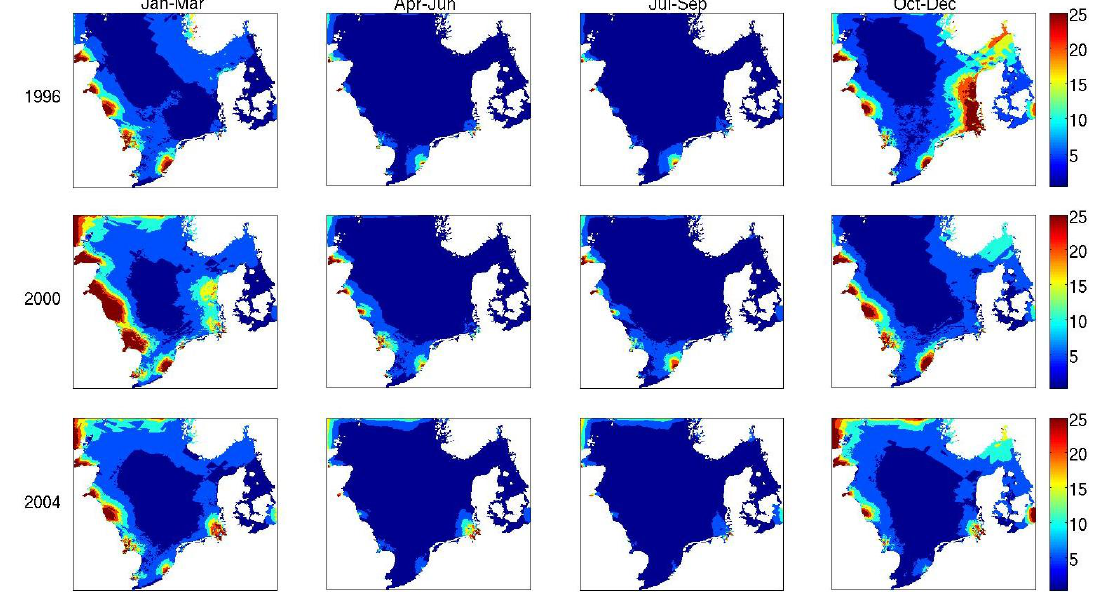
Figure 16. Distributions of quarterly (3 month) averaged fugacity ratios for PCB 153 in 1996, 2000 and 2004, calculated as the ratio of volatilization to gas